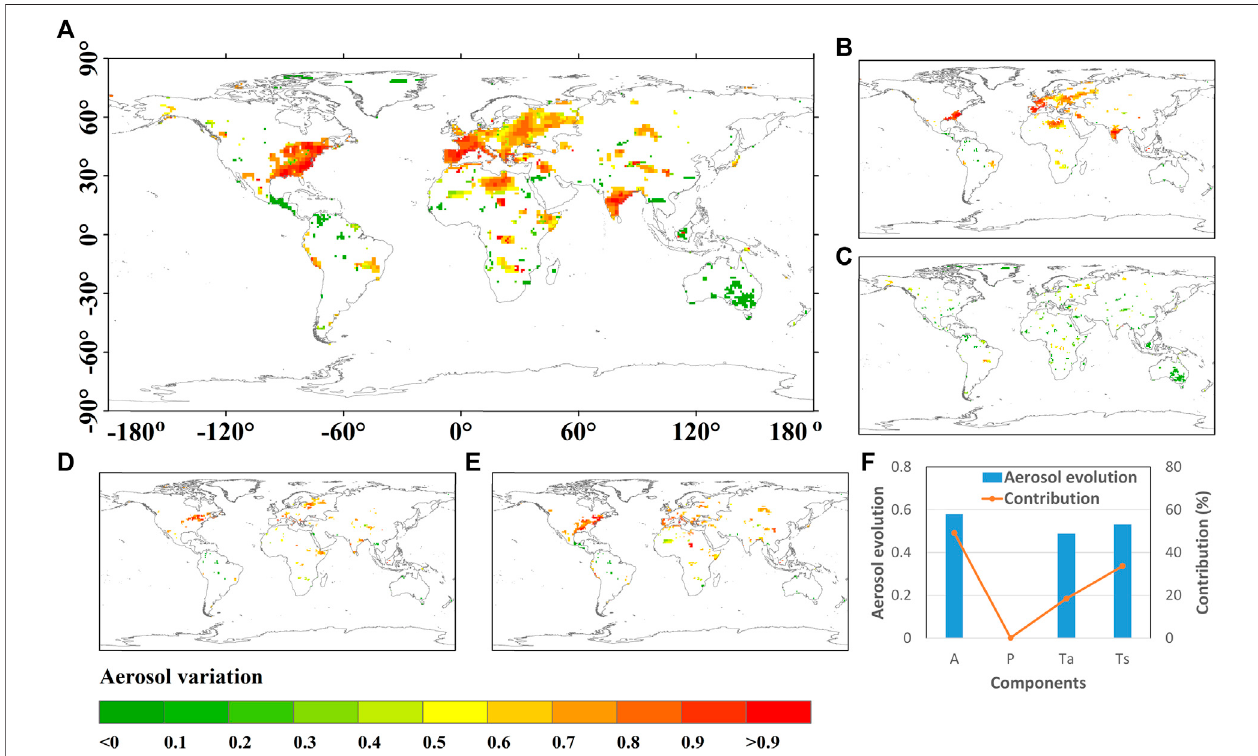
FIGURE3| Spatialpatternsoftheglobalaerosolvariation (A) ,thecomponentsof (B) initialaerosol (C) precipitation (D) airtemperatureand (E) surfacetemperature and the contribution to global variation (F) . The blank regions indicate that no variables enter the stepwise MLR model.